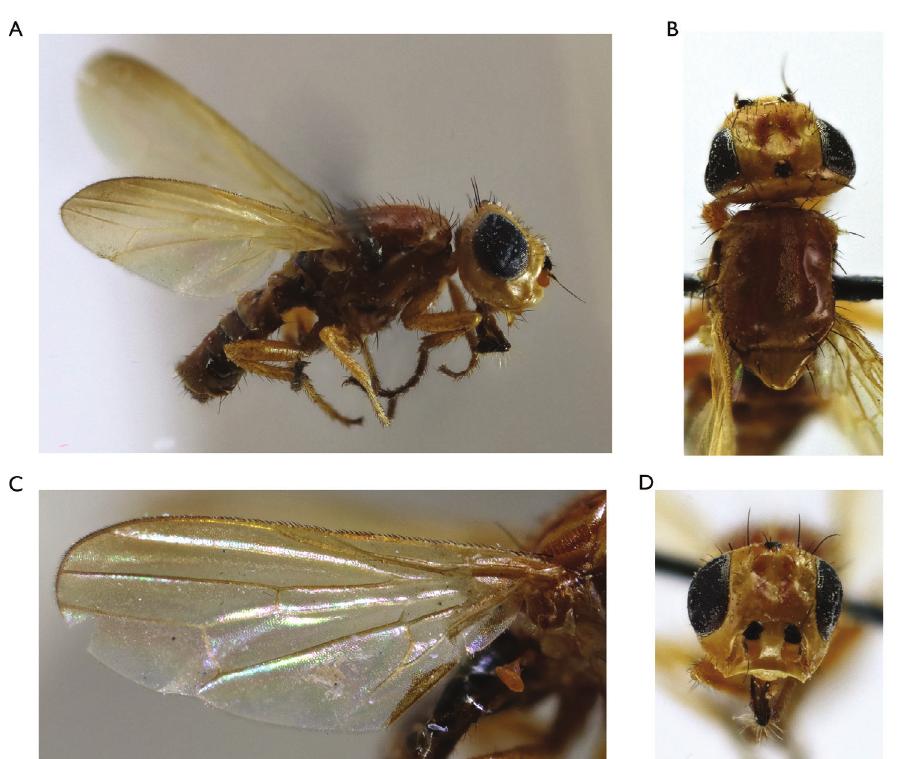
Figure 6. Timia dimidiata Becker, 1906, male A habitus, lateral view B head and thorax, dorsal view C wing D head, anterior